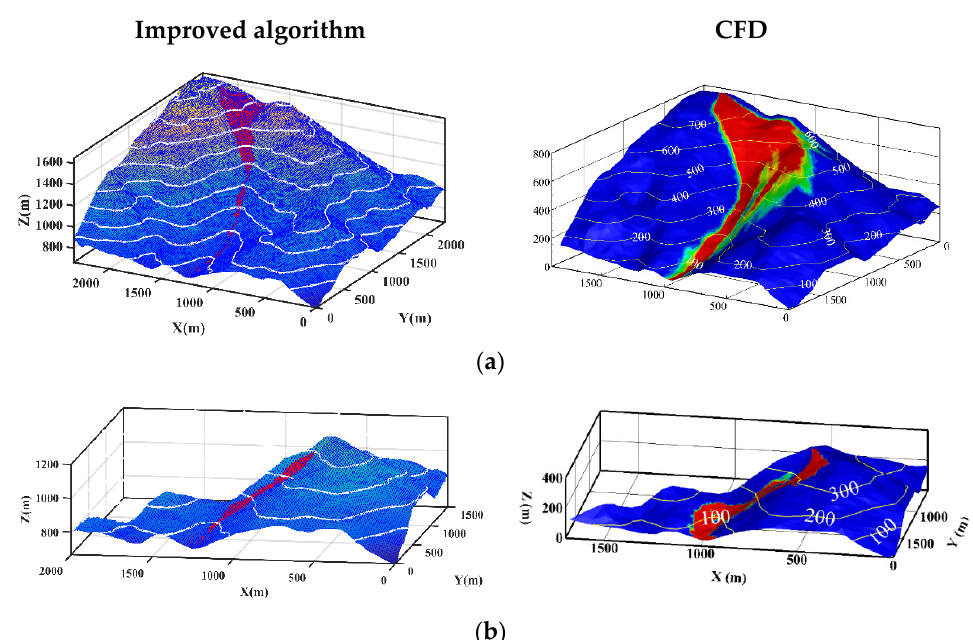
Figure 11. Comparison between the improved algorithm with CFD (v = 30 m/s): ( a ) Leakage in the valley; ( b ) Leakage at the ridge.